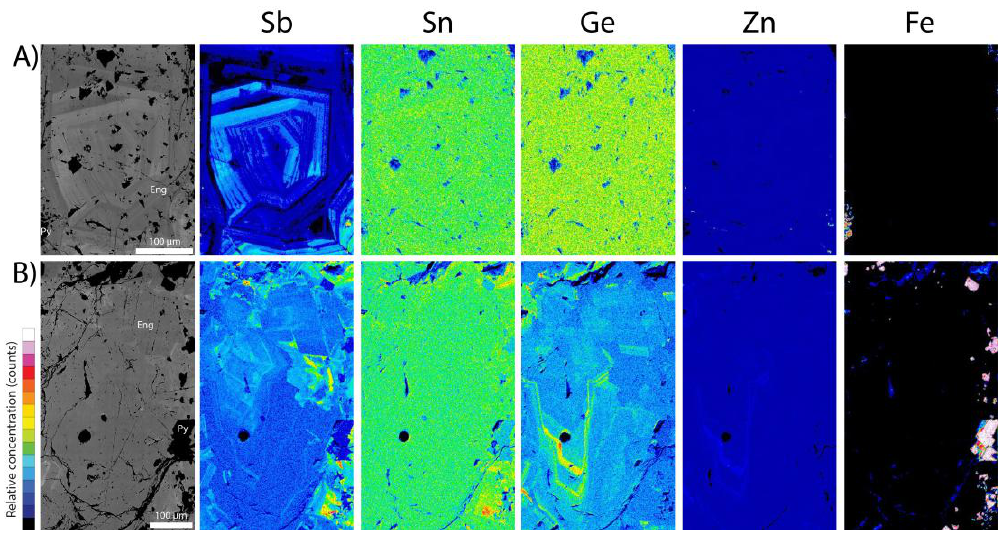
Figure 8. BSE images (left) and X-ray intensity maps of selected elements in enargite. ( A ) Enargite crystal from Mt Carlton showing an oscillatory zoning primarily related to Sb content. Zinc and Ge are homogenously distributed in the crystal, while Sn shows a faint enrichment in Sb-rich zones. ( B ) Zoned enargite crystal from La Mejicana. Growth zones enriched in Ge are also enriched in Zn. A relatively homogenous distribution is observed for Sn, but locally it shows high enrichments in areas also marked by a high Sb content. Mineral abbreviations: Eng—enargite; Py—pyrite.